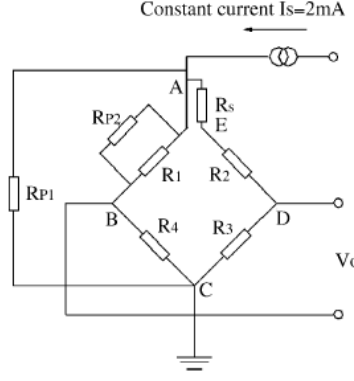
Figure 1. Typical compensation circuit in a low-temperature coefficient resistor network